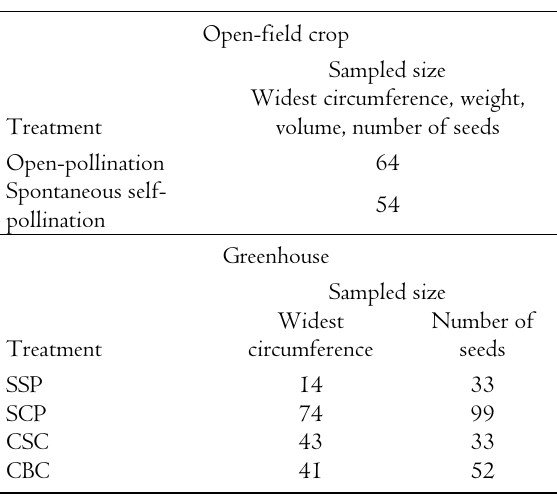
T ABLE 1. Number of fruits of tomato measured for each parameter of quality after pollination treatments, performed in open-field crops (São José de Ubá) and in a greenhouse (Campos dos Goytacazes). SSP = spontaneous self-pollination, SCP = supplemental manual cross pollination, CSC = manual cross pollination in the same cultivar, CBC = manual cross pollination between